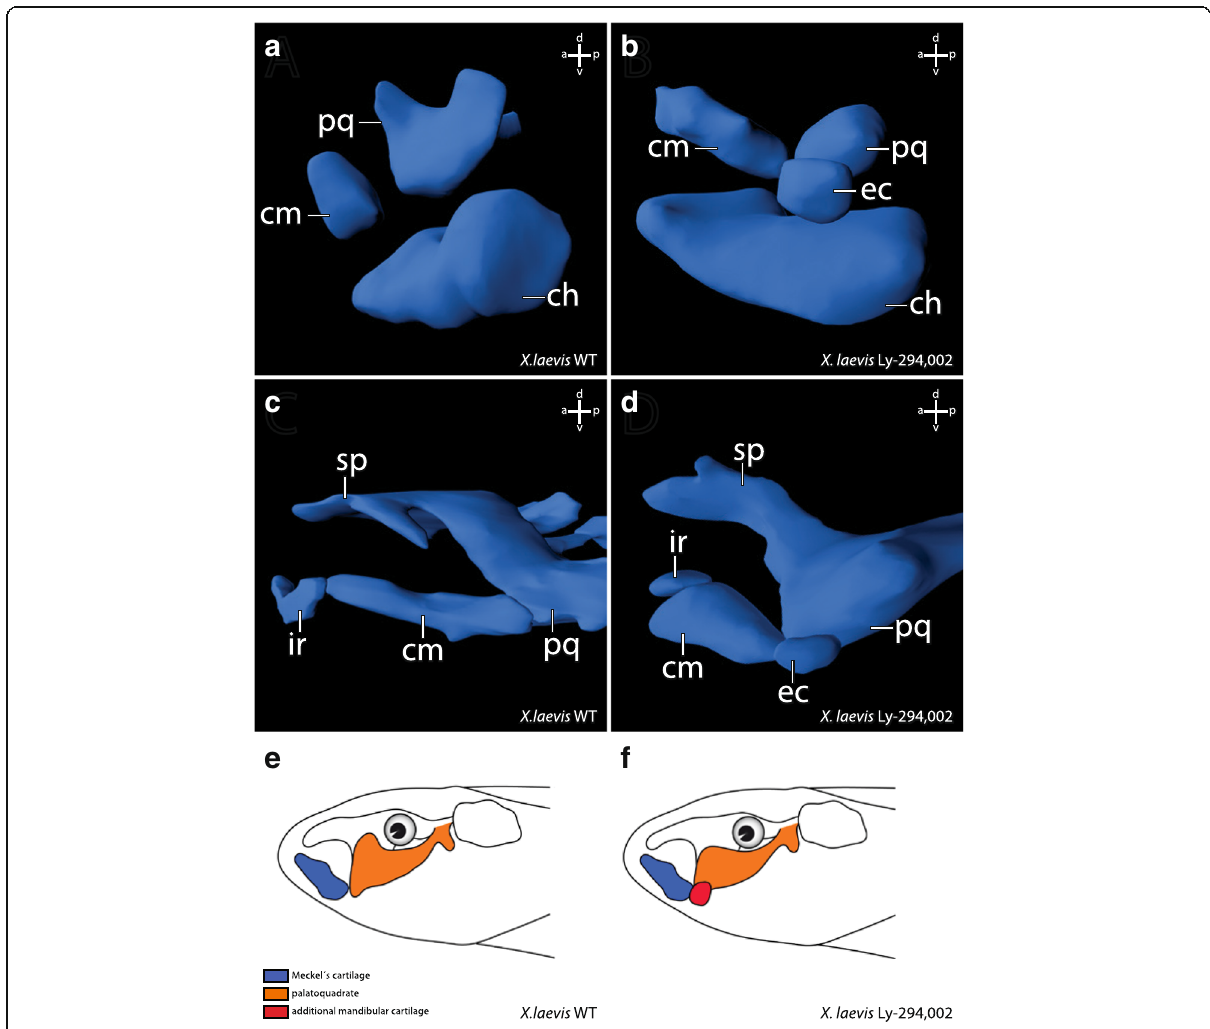
Fig. 3 3D reconstructions based on confocal laser scanning microscopy showing the effects of Ly-294,002 treatment on cranial cartilage morphology in Xenopus laevis larvae. Lateral view of ZO 10 ( a , b ) and ZO 17 ( c , d ) larvae with normal bapx1 expression (left column) and elevated bapx1 expression (right column). In Ly-294,002-treated specimen with increased bapx1 expression an ectopic cartilage develops within the mandibular arch lateral to the palatoquadrate. Depictions of X. laevis larvae in lateral view show the main differences between e normal and f perturbed development. In short, the processus muscularis is reduced in size and an ectopic cartilage arises lateral to the palatoquadrate after upregulation of bapx1 . ch, ceratohyal; cm, Meckel ’ s cartilage; ec, ectopic cartilage; ir, infrarostral cartilage; pq, palatoquadrate; sp., suprarostral